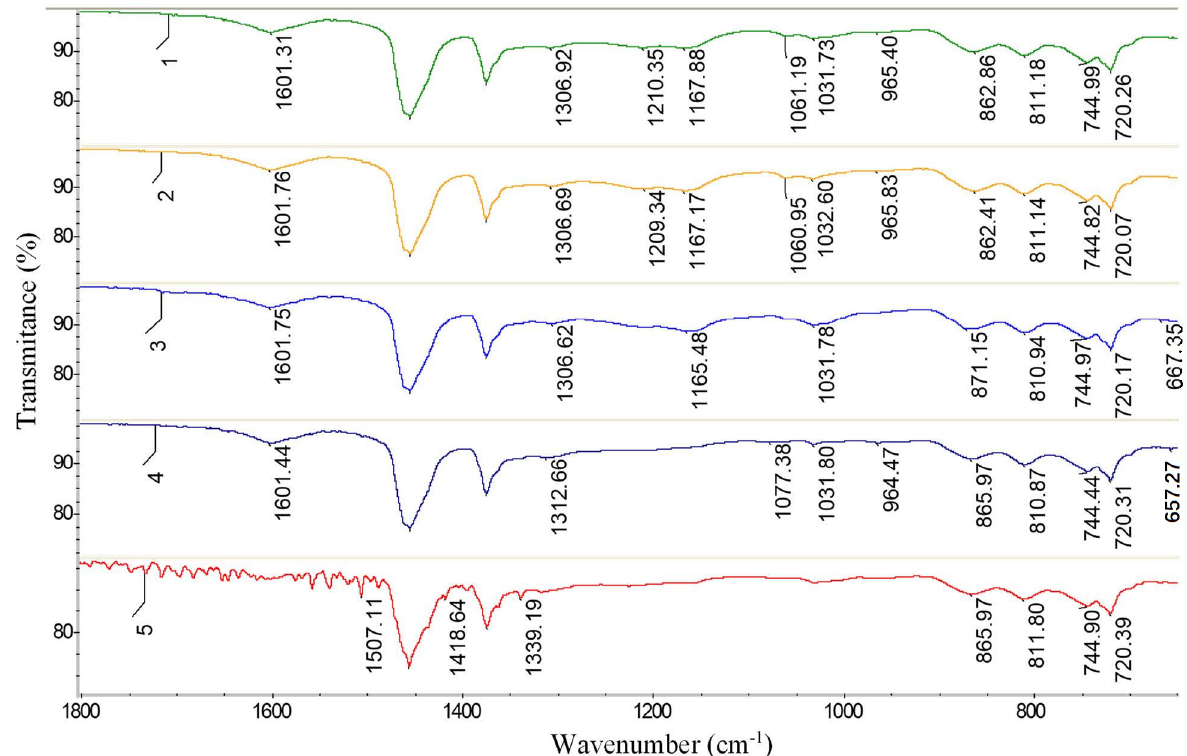
Figure 13. FTIR spectrum (1800–650 cm − 1 ): 1—FTM-1; 2—FTM-2; 3—FTM-3; 4—FTM-4;